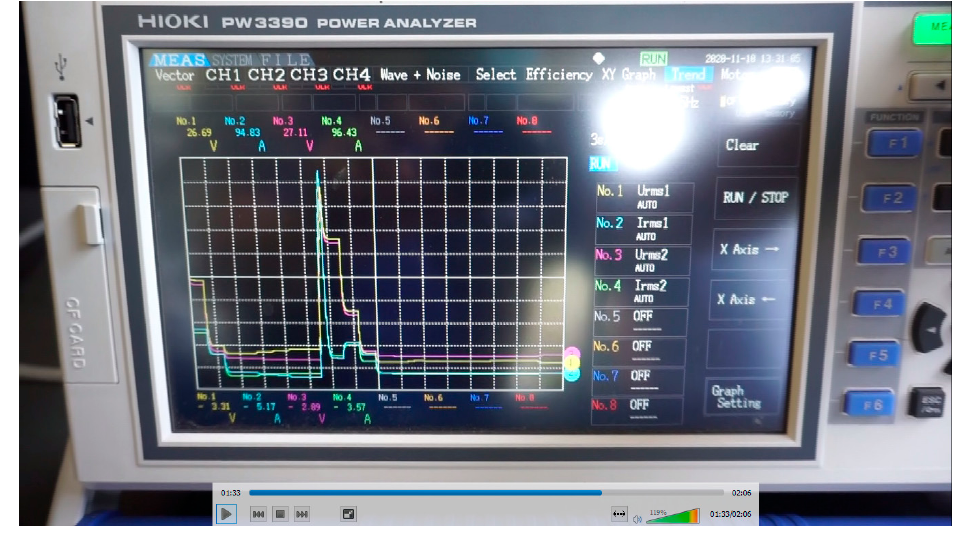
Figure 8. Power analyzer display.